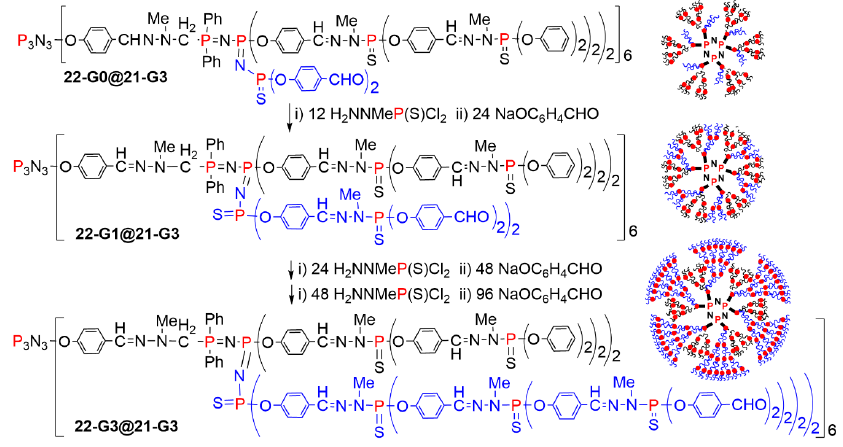
Scheme 22. Synthesis of branches inside a dendrimer, up to 22-G3@21-G3